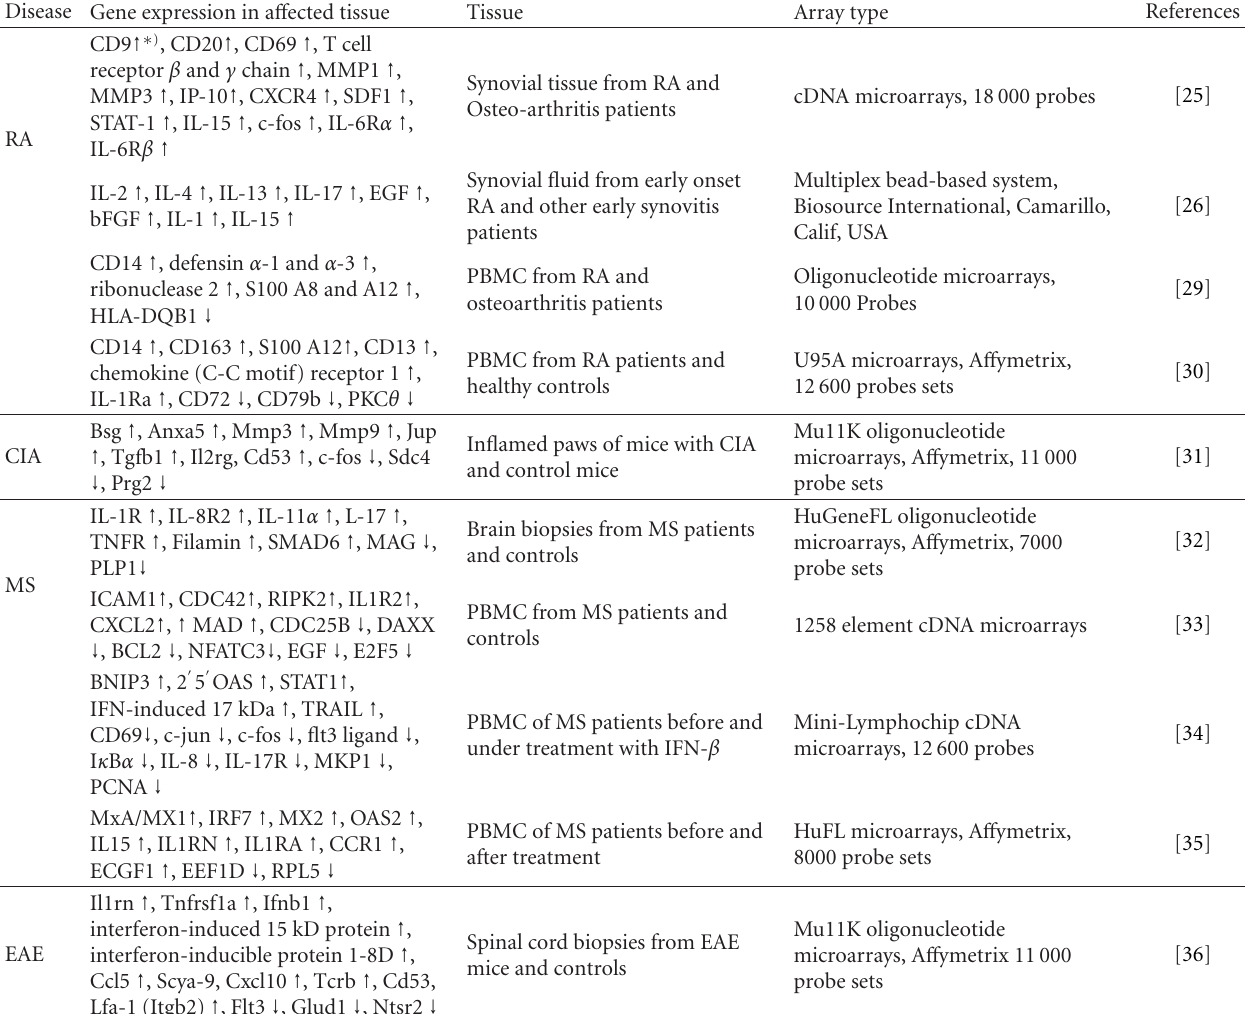
Table 1: DNA microarray studies on rheumatoid arthritis (RA), collagen-induced arthritis (CIA), multiple sclerosis (MS), and experimental allergic encephalitis